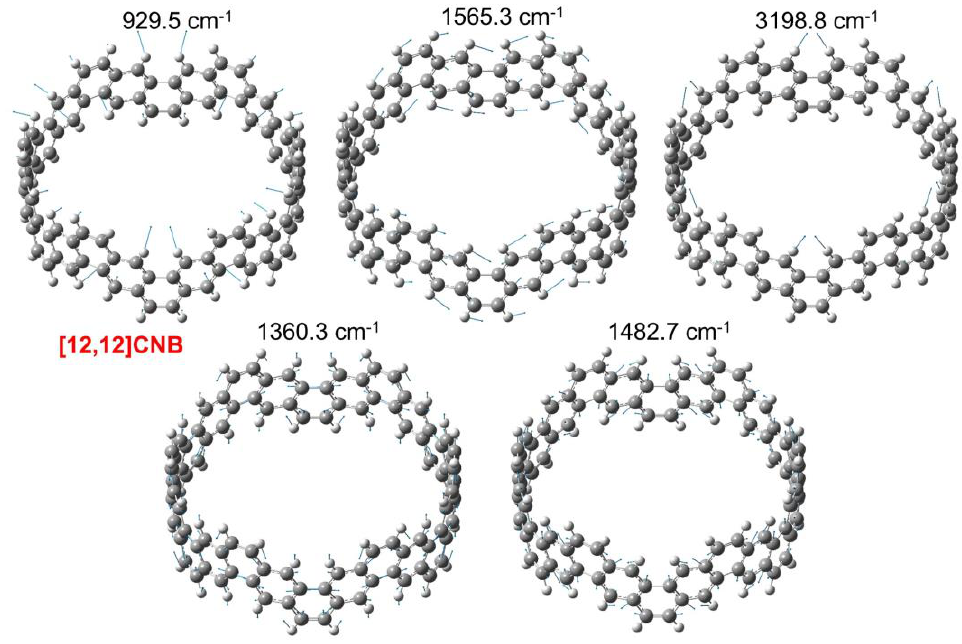
Figure 8. IR spectra ( a ) and Raman spectra ( b ) of [2N, 2N]CNB. The peaks of the infrared and Raman spectra are broadened by the Lorentz function, FWHM = 8.0 cm −1.